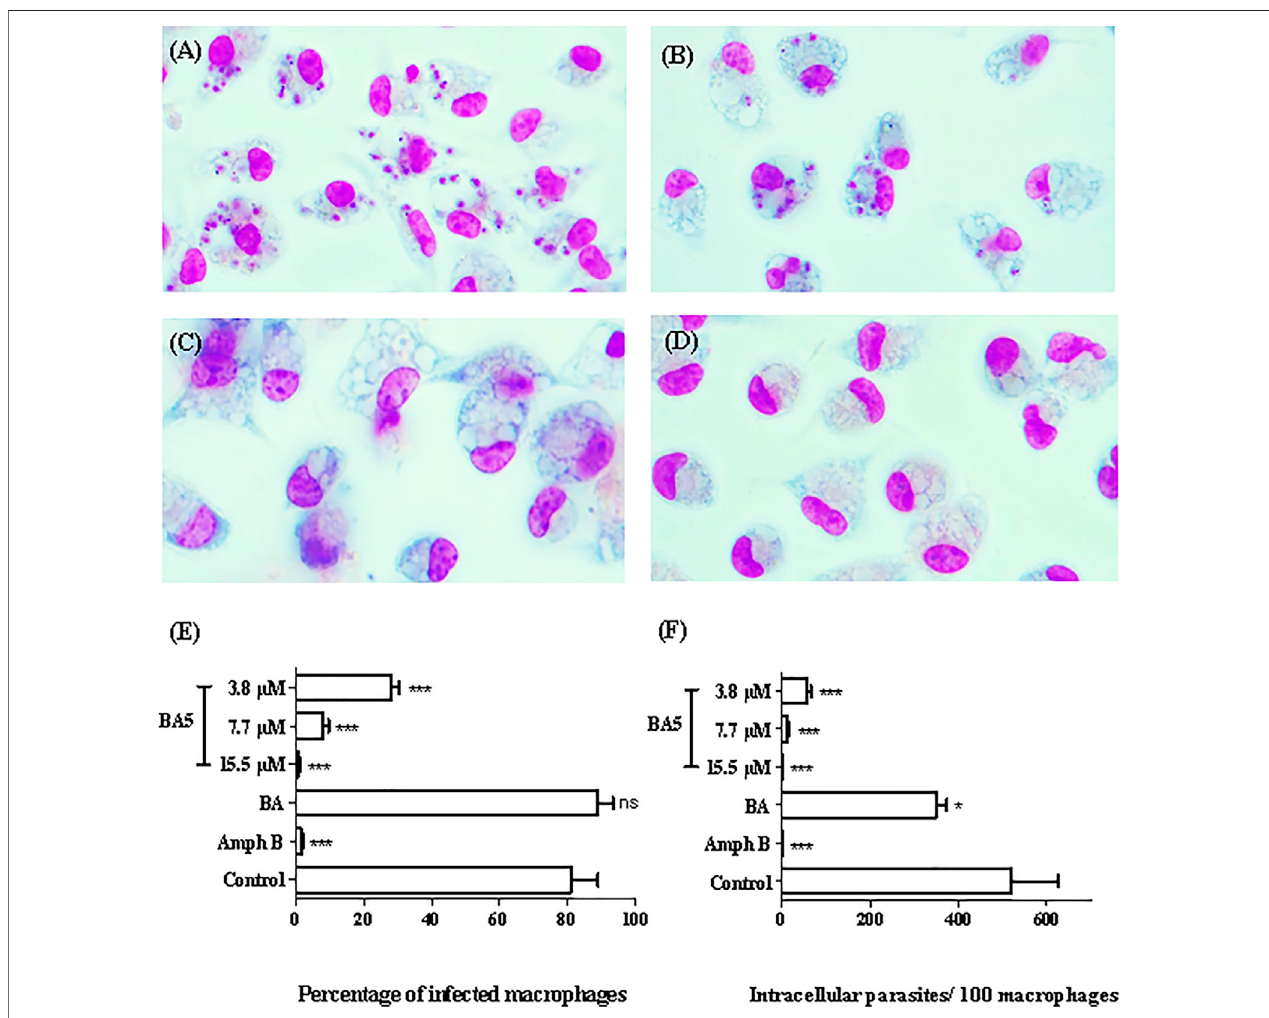
FIGURE 2 | In vitro effects of BA and BA5 against intracellular parasites of L. amazonensis . Peritoneal macrophages of BALB/c mice were infected with promastigotesof L.amazonensis atstationaryphase(10:1)andweretreatedwithBAorBA5for24 h. (A) Untreatedcontrol. (B) TreatmentwithBAat9.4 µM. (C) BA5at